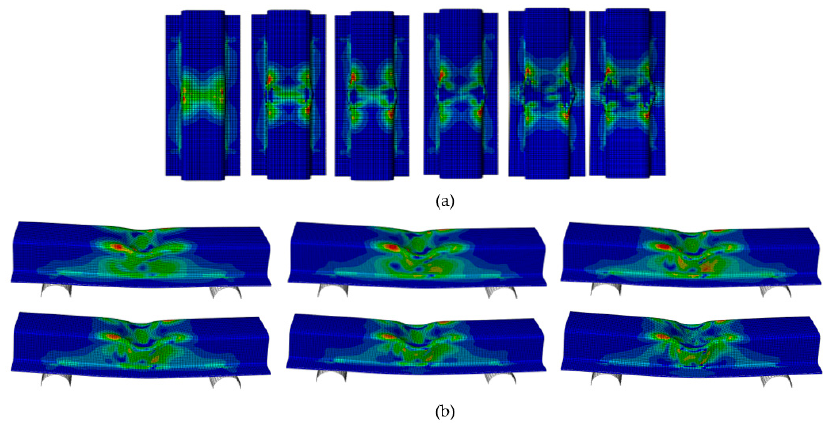
Figure 8. Different time steps for dynamic transverse loading at a speed of 3.5 m/s, ( a ) top view ( b ) side view .